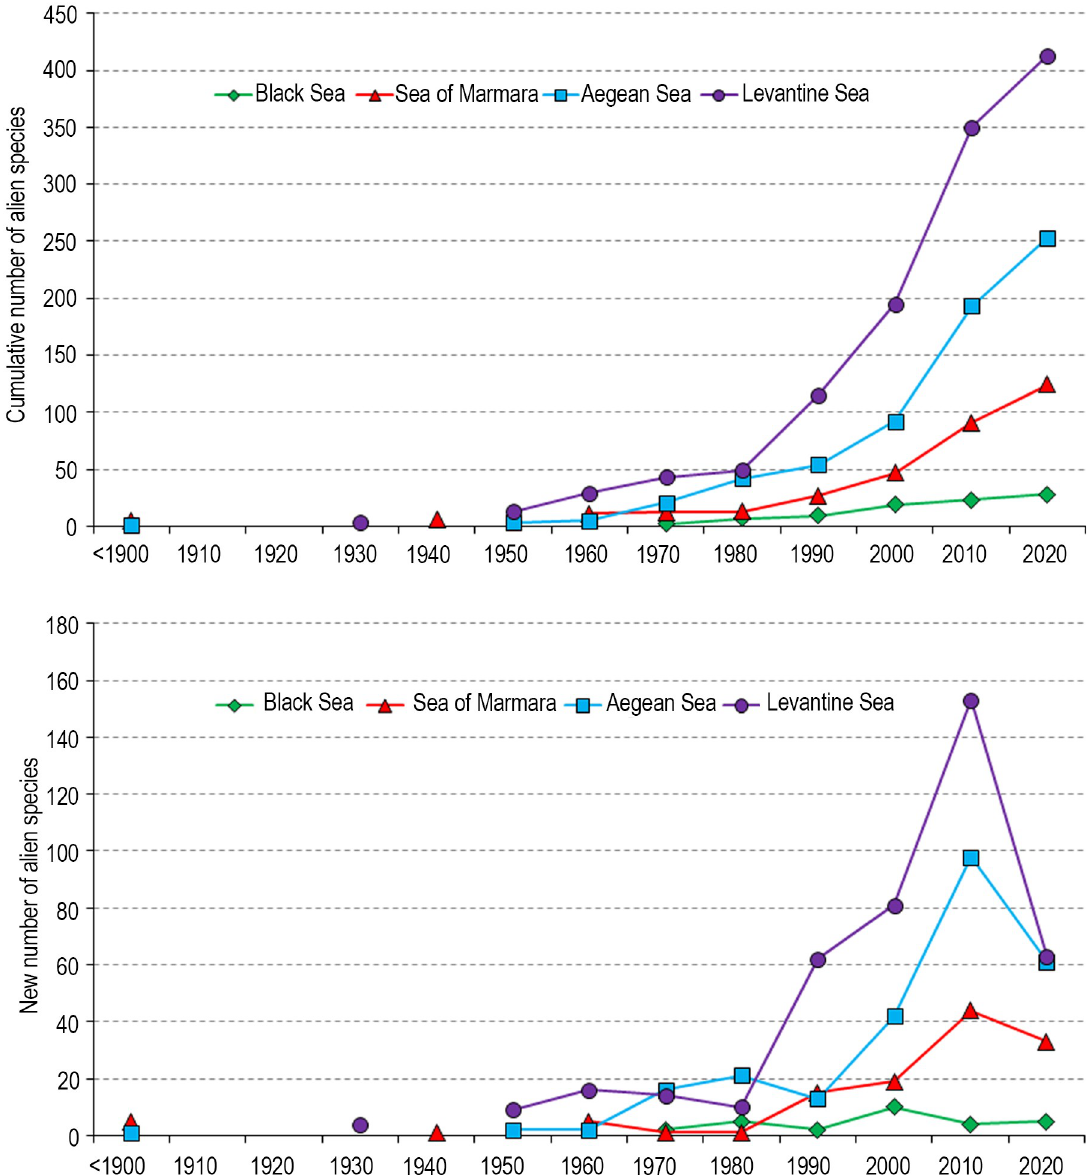
Fig 8. Cumulative (upper) and new (lower) number of alien species in seas surrounding Turkey over years.